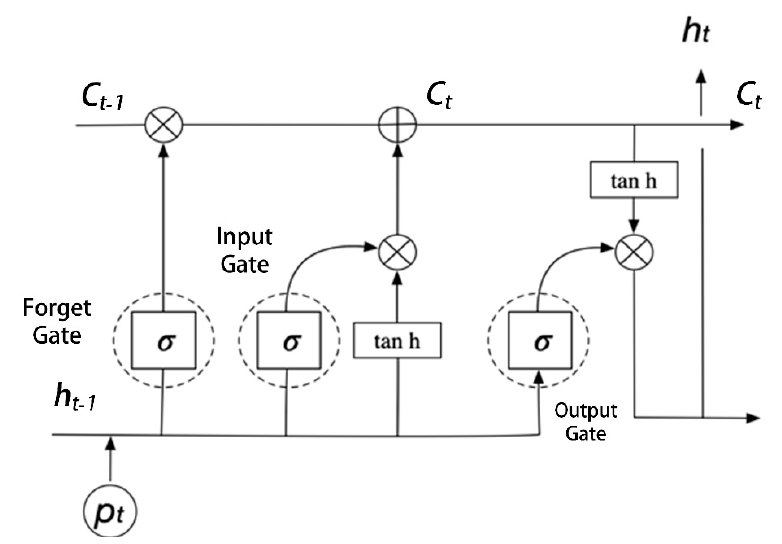
Figure 3. Internal structure of LSTM model.